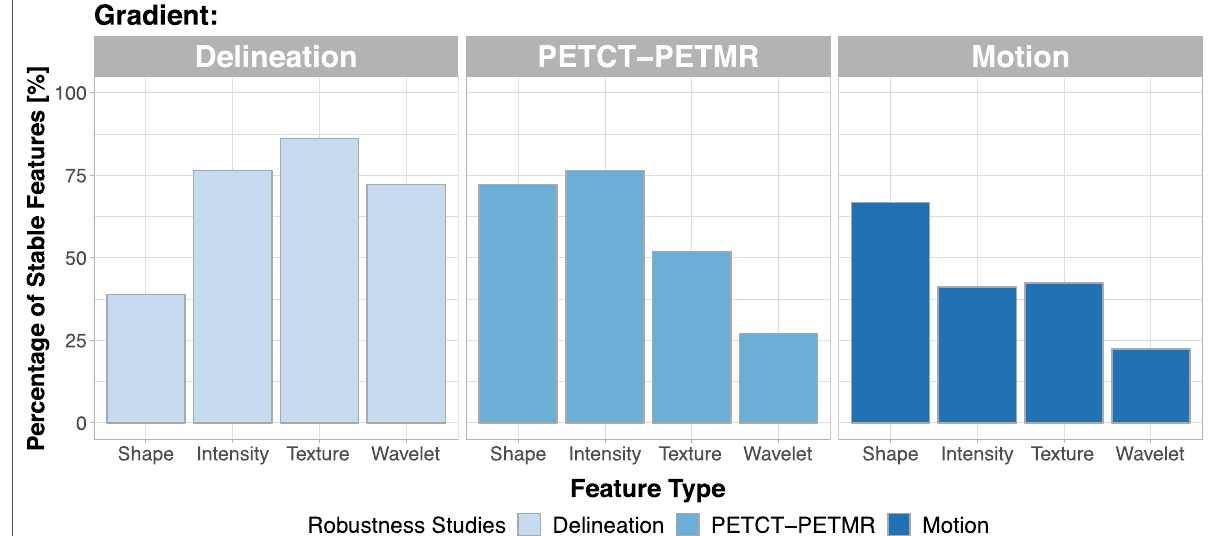
Fig. 3 Robust radiomic features. Percentage of stable features for each of the robustness studies, i.e. the interobserver delineation variability, PET/ CT/PET/MR, and respiratory motion are depicted. For each robustness study, the percentage of stable features is shown for the four feature types: shape, intensity, texture and wavelet. The feature type with the highest stability differed between the studies, with the lowest stability in the delineation study being shape, and wavelet in the PET/CT / PET/MR and motion studies